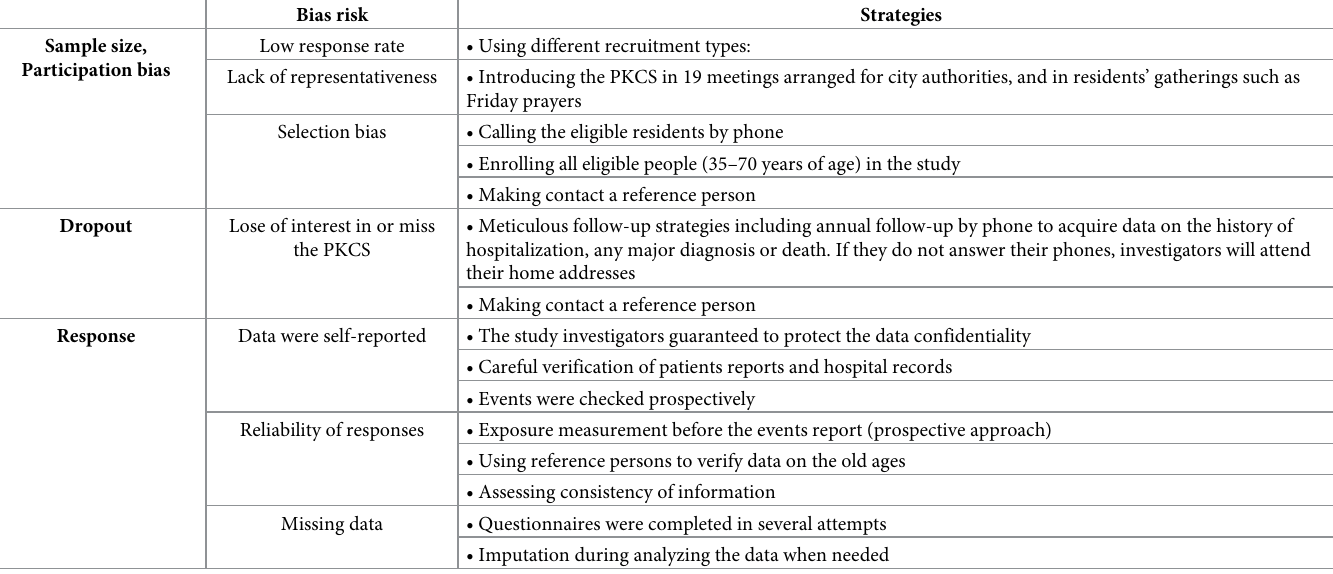
Table 5. The risks of bias in the PERSIAN Kavar Cohort Study (PKCS) and strategies for their maximum